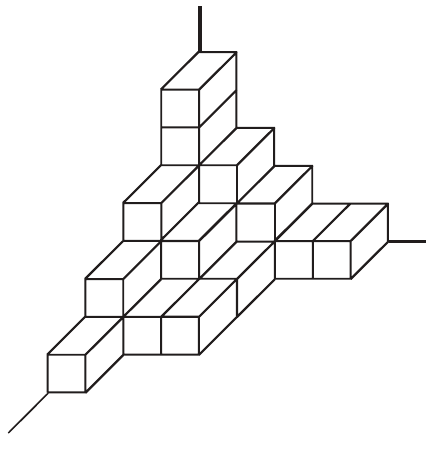
Figure 1: Plane partitions represent melting crystal configurations of C 3